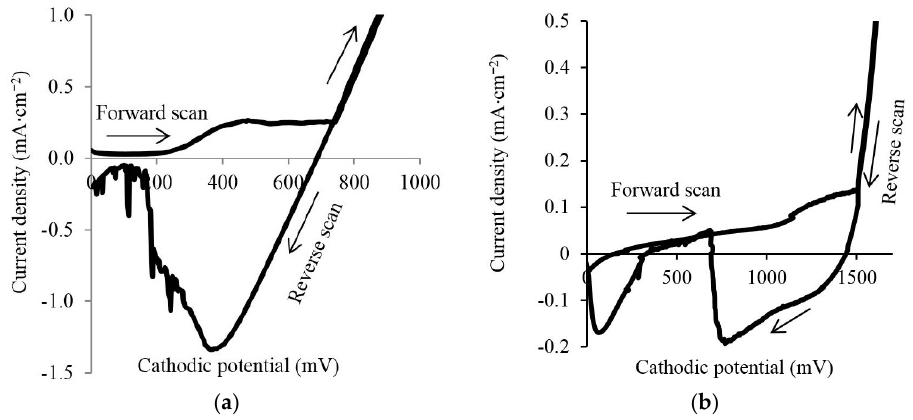
Figure 1. Cyclic voltammograms of aqueous solutions consisting of 1 M CdSO 4 and a low level of TeO 2 with glass/FTO cathode in ( a ) three ‐ electrode (3E) and ( b ) two ‐ electrode (2E) systems. The reference electrode used for the 3E system is a standard calomel electrode. The growth temperature was 70 °C and 85 °C for the 3E and 2E systems, respectively. The pH of both electrolytes was set to 2.00 ± 0.02 at the beginning of the experiment at room temperature.